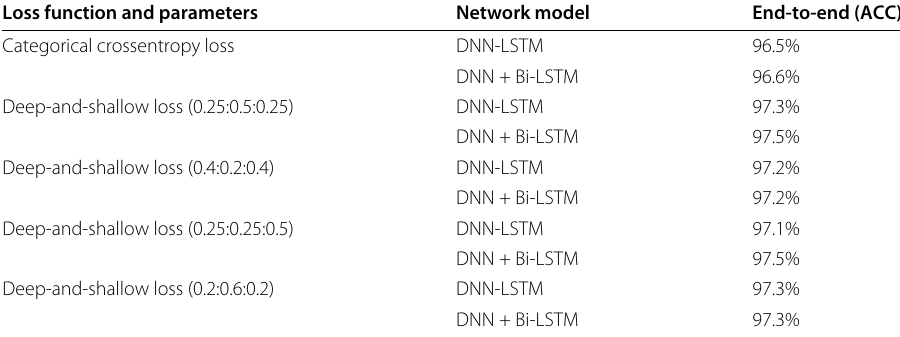
Table 7 Comparison experiment of weight selection based on deep-and-shallow loss and single loss Loss function and parameters Network model End-to-end (ACC) Categorical crossentropy loss DNN-LSTM 96.5% DNN + Bi-LSTM 96.6% Deep-and-shallow loss (0.25:0.5:0.25) DNN-LSTM 97.3% DNN + Bi-LSTM 97.5% DNN-LSTM 97.2% DNN + Bi-LSTM 97.2% DNN-LSTM 97.1% DNN + Bi-LSTM 97.5%